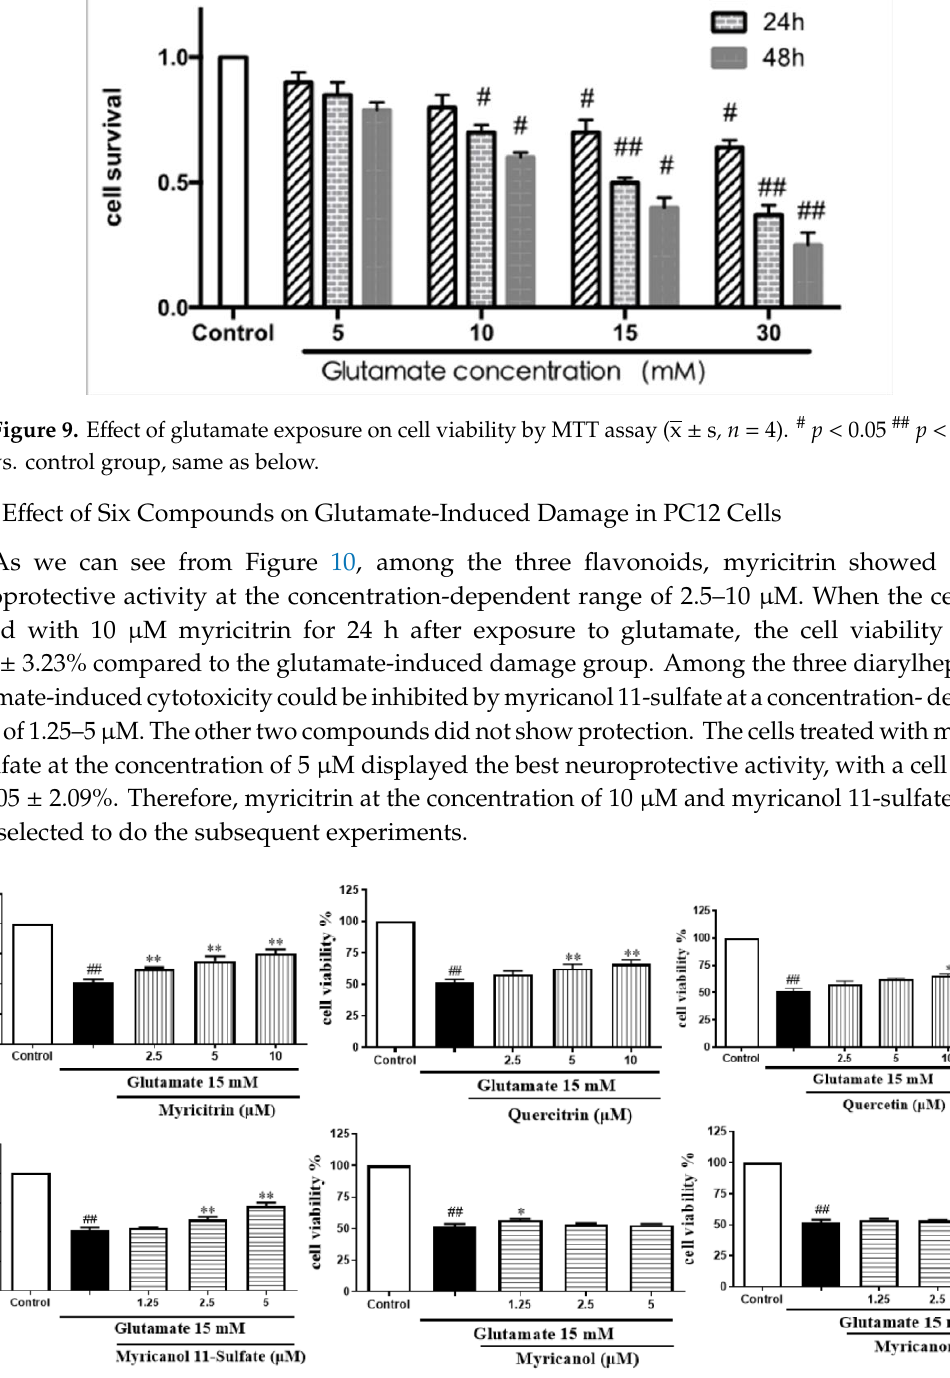
Figure 10. Effects of six major compounds on glutamate-induced PC12 cells through the MTT test (x ± s, n = 4 ) * P < 0.05 ** P < 0.01 vs. glutamate group; ## P < 0.01 vs. control